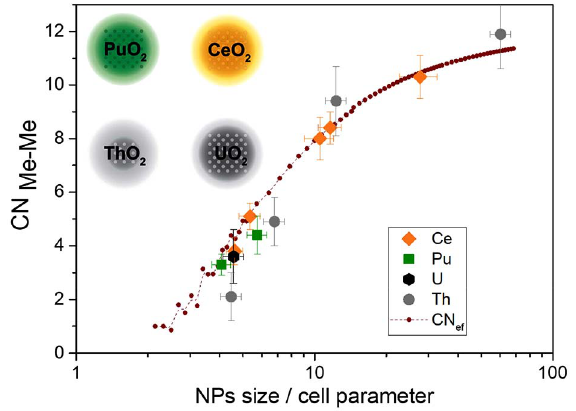
Figure 4 Changes in Me–Me CN with NP size in the series UO 2 –ThO 2 –CeO 2 – PuO 2 . Data for ThO 2 (Plakhova et al. , 2019) and UO 2 NPs (Gerber et al. , 2021) were taken from our previously published papers.